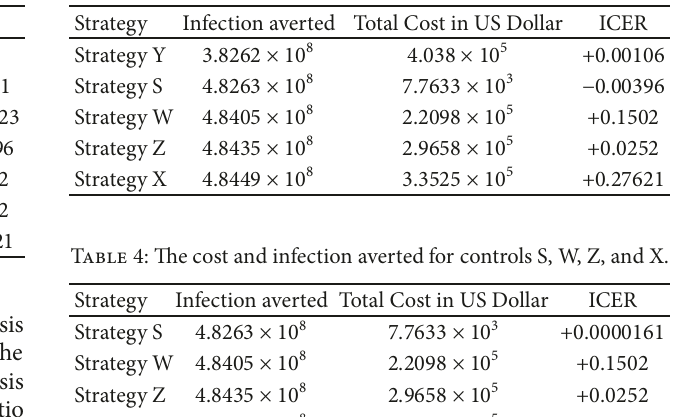
Table 3: The cost and infection averted for controls Y, S, W, Z, and X.